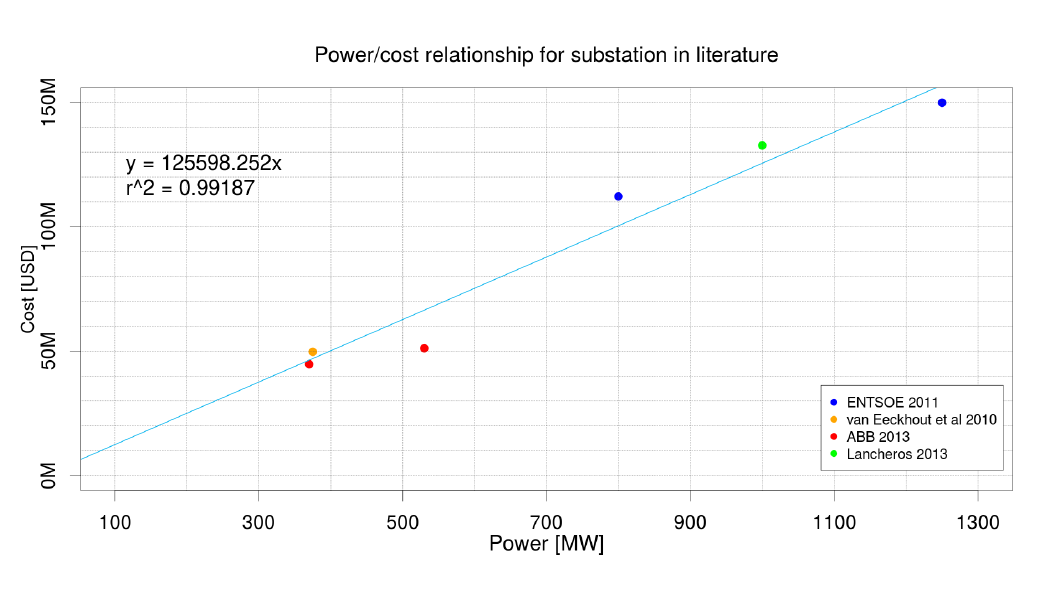
Figure 5. Relationship between power and construction cost for substations.